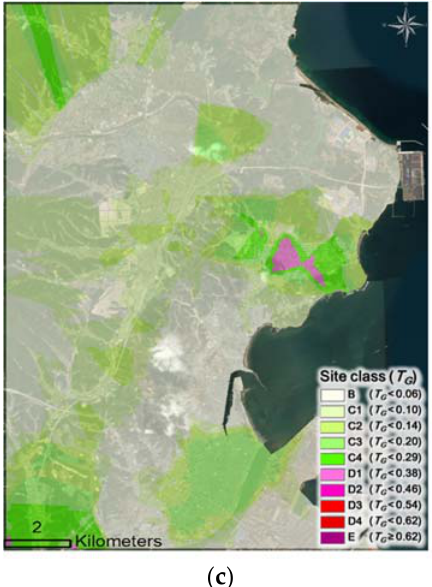
Figure 6. Seismic zonation for geotechnical response-parameter-based, site-specific effects: ( a ) H ; ( b ) V S 30 ; ( c ) T G .